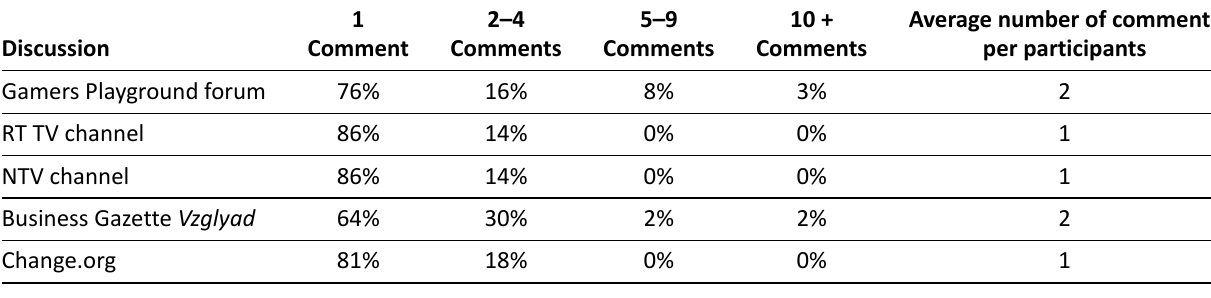
Table 2. Distribution of participants by posted